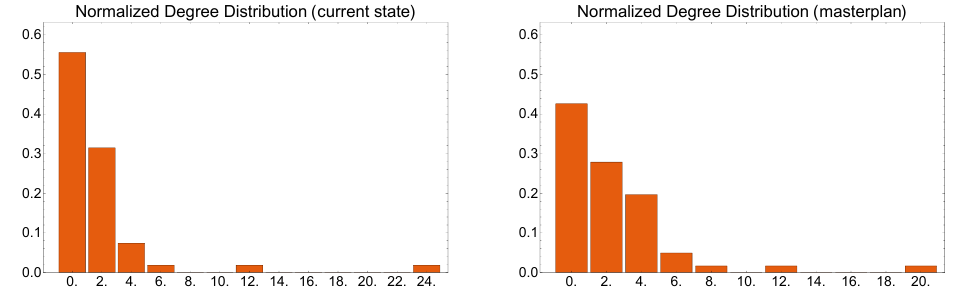
Figure 9. Degree distribution of the central archaeological area, as in the current situation ( left ) and in the project ( right ).